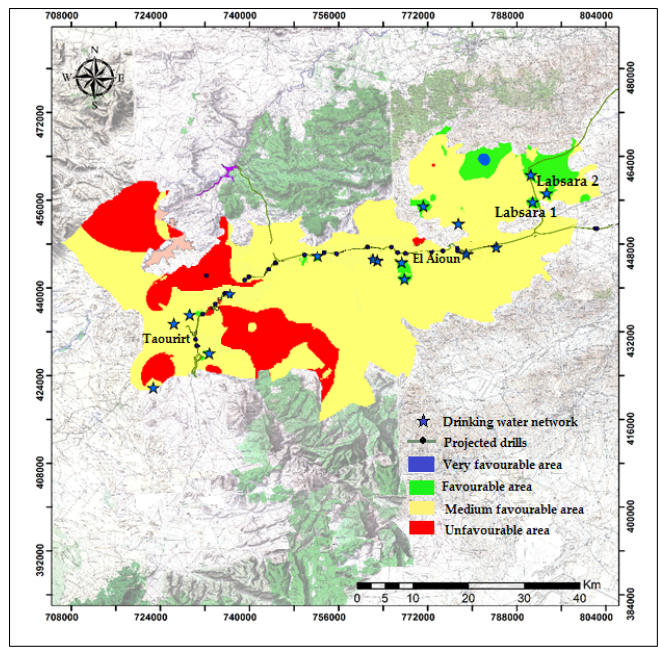
Figure 12. Sites for projected drilling.